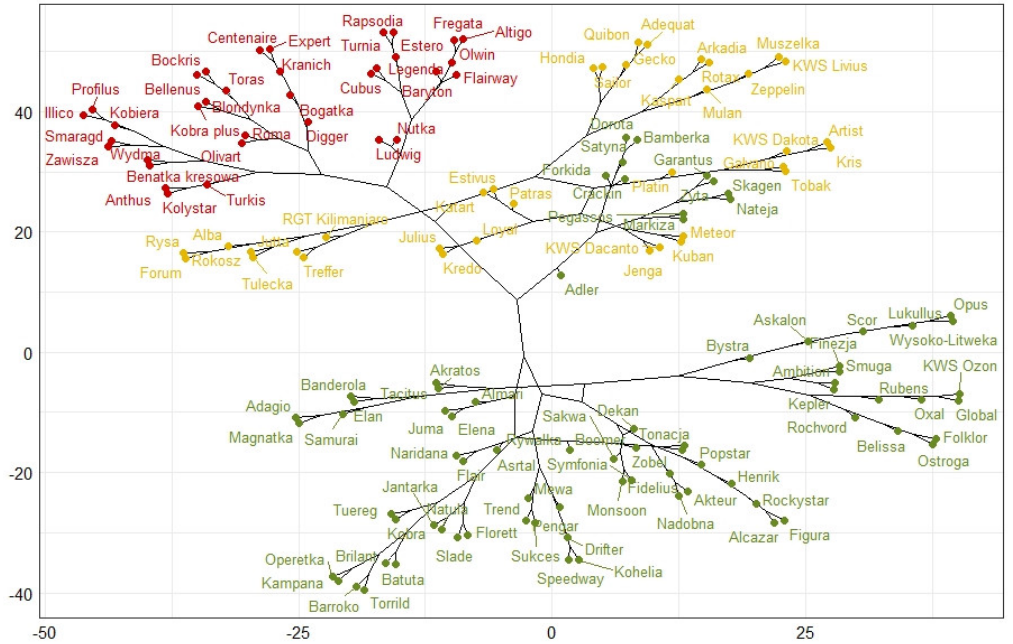
Figure 3. Distribution of the studied genotypes of plants using the method of hierarchical K−means in laboratory conditions in the inoculation of R. cerealis (clustering in the form of a phylogenetic tree). The colors correspond to the assigned clusters according to the resistance type; red − susceptible, yellow − less susceptible, green − least